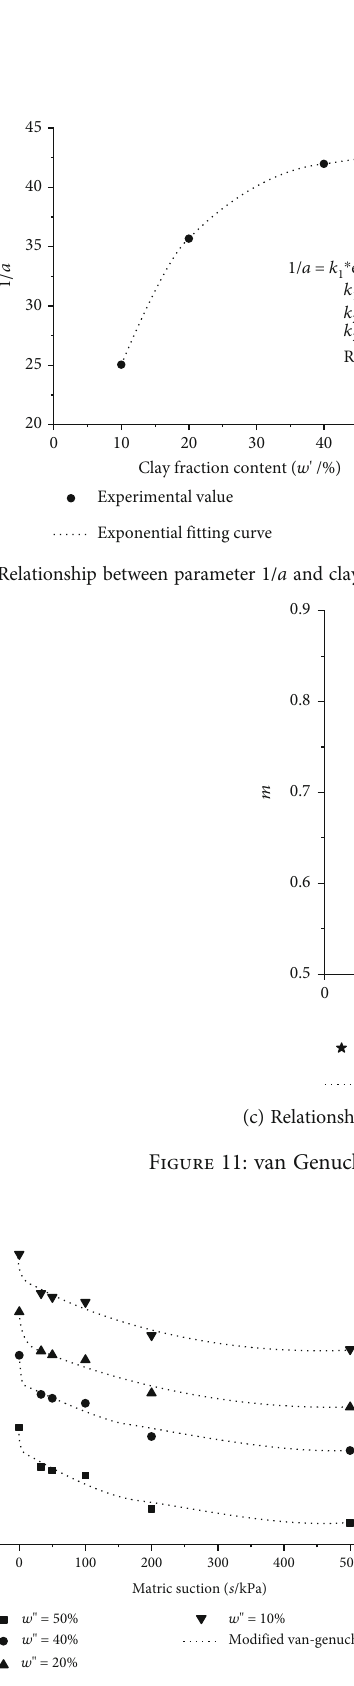
Figure 12: SWCC curves of di ff erent montmorillonite contents.